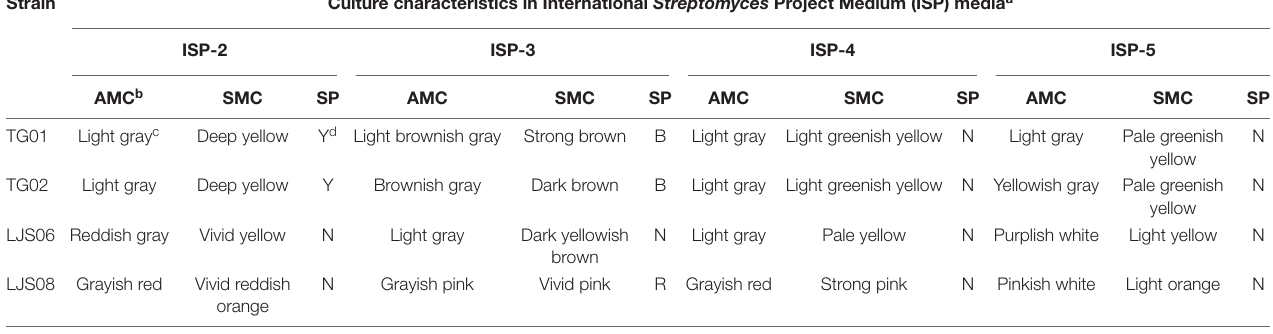
TABLE 3 | Culture characteristics of the four Streptomyces strains on ISP-2, ISP-3, ISP-4, and ISP-5 media. Strain Culture characteristics in International Streptomyces Project Medium (ISP) media a ISP-2 ISP-3 ISP-4